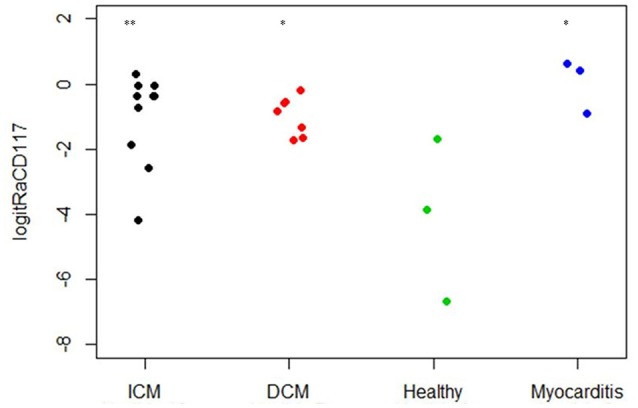
Relative area of CD117 per tissue section (n = 23). The X axis designates the patient groups: ICM (n = 10), DCM (n = 7), Healthy (n = 3), and Myocarditis (n = 3). The Y axis presents the relative area of CD117+ signals (total area of signals divided by total area of tissue section; Table 2), converted to logit scale [logit(p) = log (p/(1 – p))]. Individual values are presented as spots. The expression of CD117 is significantly higher in ICM, DCM and Myocarditis, compared to healthy (*P < 0.05 vs. healthy, **P < 0.01 vs. healthy).